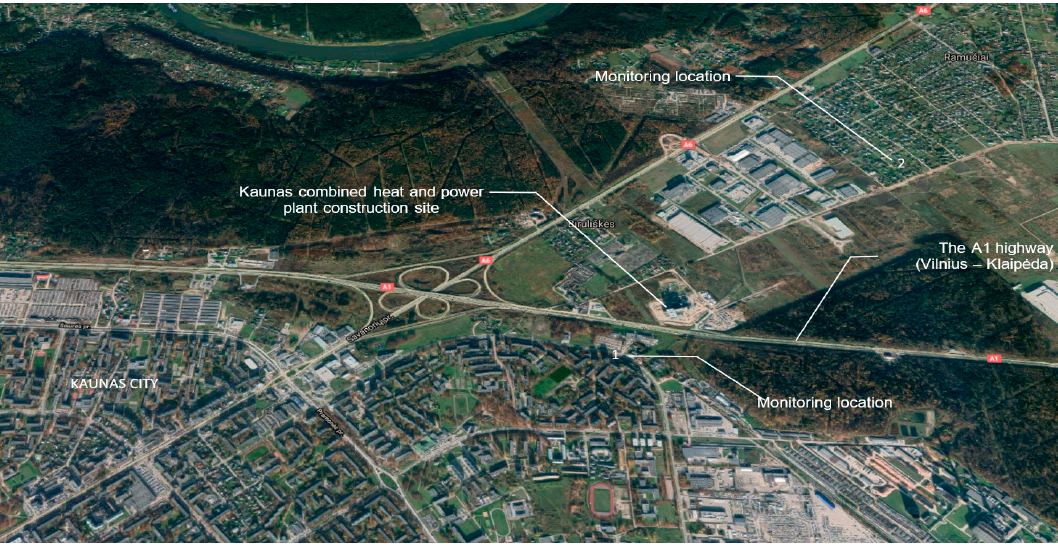
Figure 2. Map of Kaunas Combined Heat and Power Plant construction site and PCDD/F measurement location.